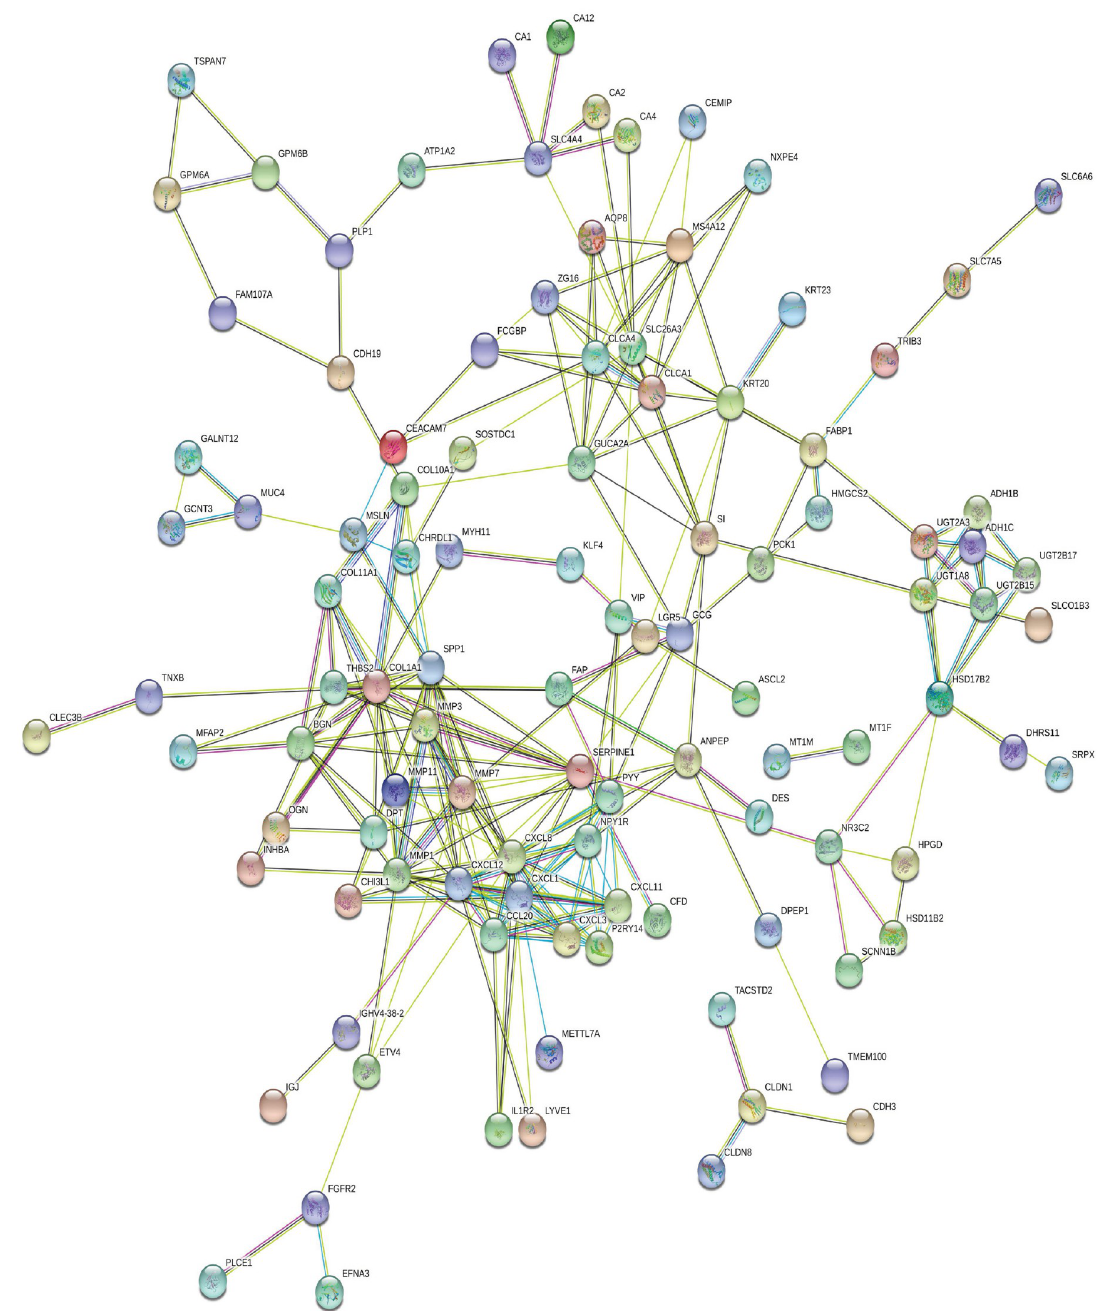
Fig 17. Protein protein interactions network based on the STRING